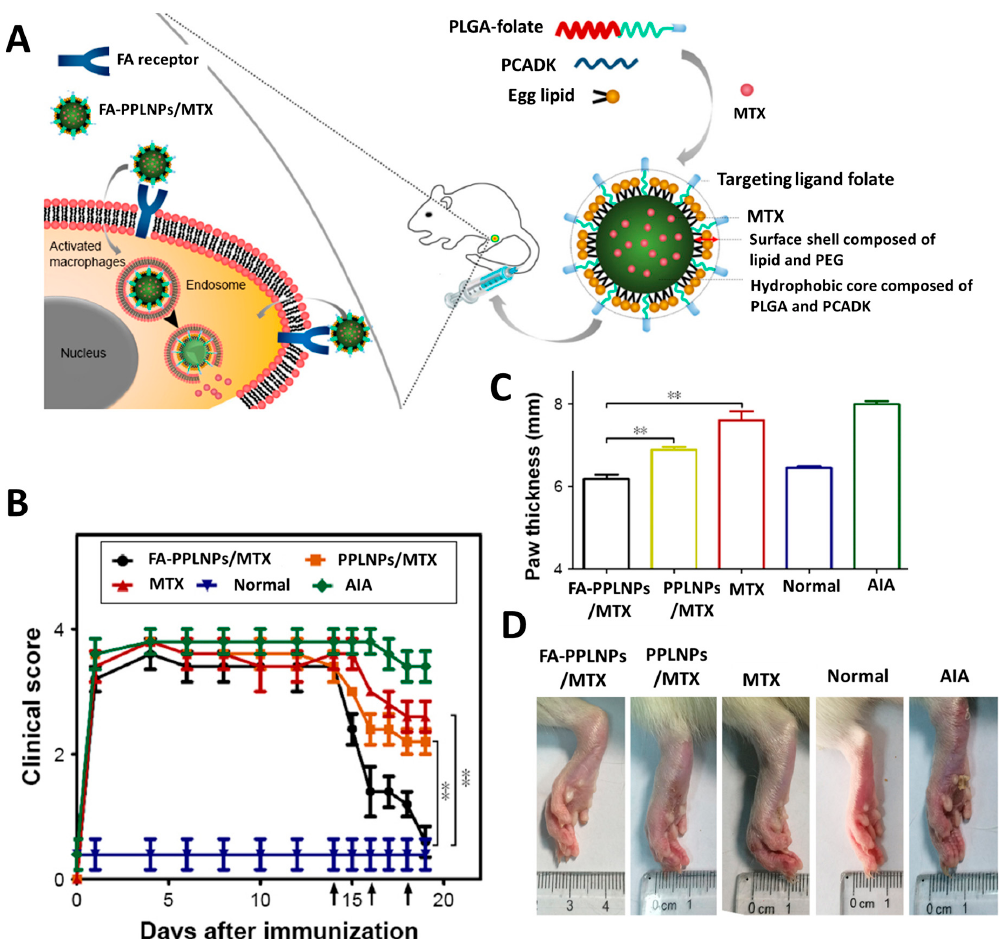
Figure 3. Polymeric NP for active cellular targeted delivery of methotrexate (MTX) to